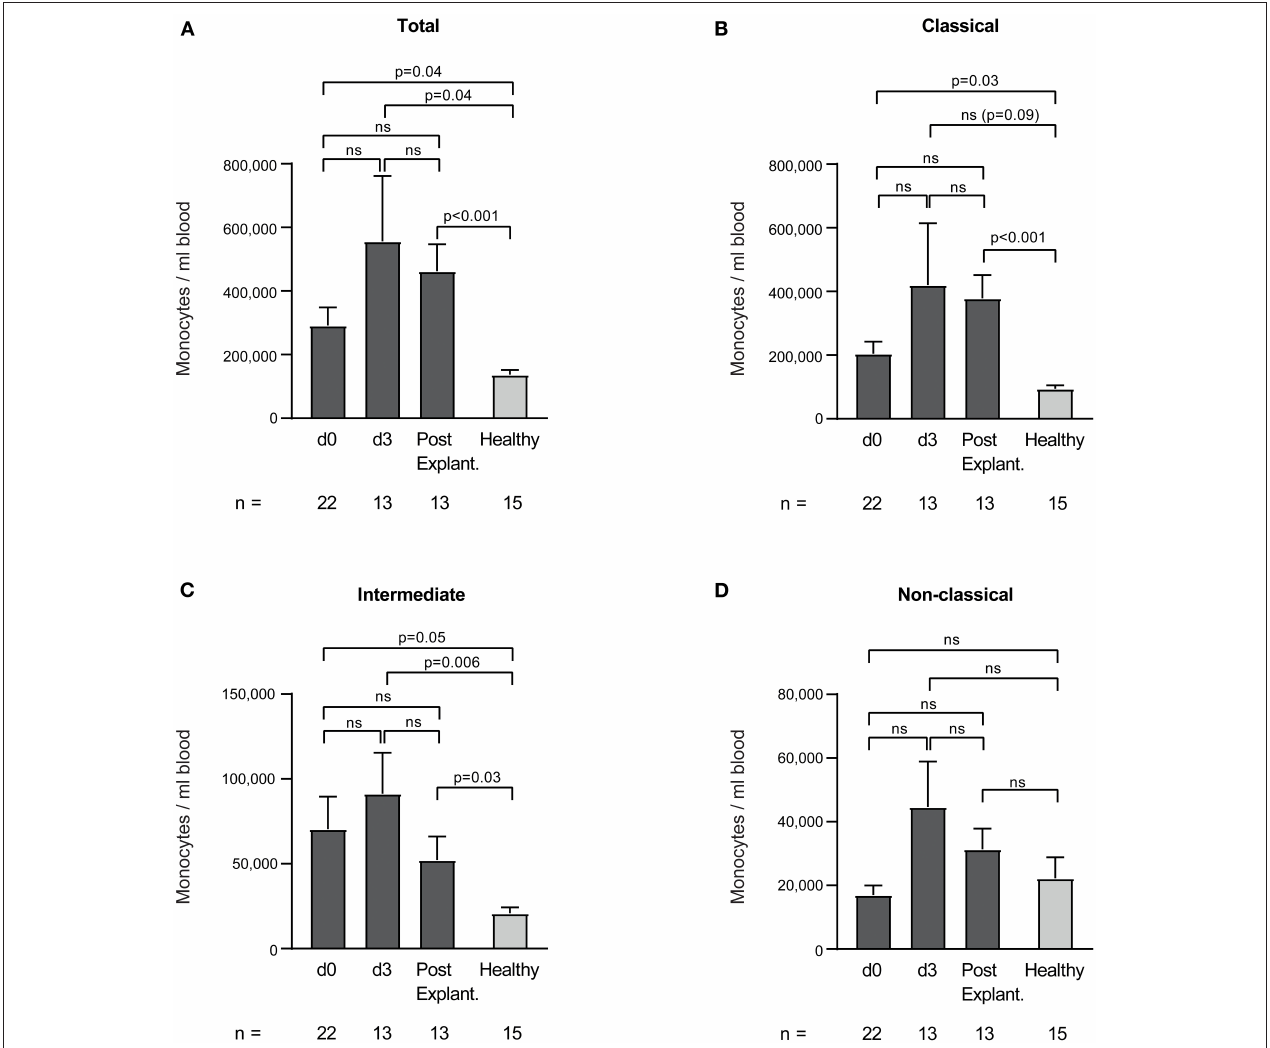
FIGURE 6 | Total (A) , classical (B) , intermediate (C) , and non-classical (D) monocyte counts per ml blood in patients receiving veno-arterial extracorporeal membrane oxygenation on different days (d0, d3) and after explantation (post explant.) compared to healthy controls. The number of remaining patients at every time point is indicated below. Data are presented as mean ± SEM. Mixed effects models were used to analyze differences between means across different time points (d0, d3, and post explantation vs. each other). Unpaired t -tests were used to analyze differences of means at single time